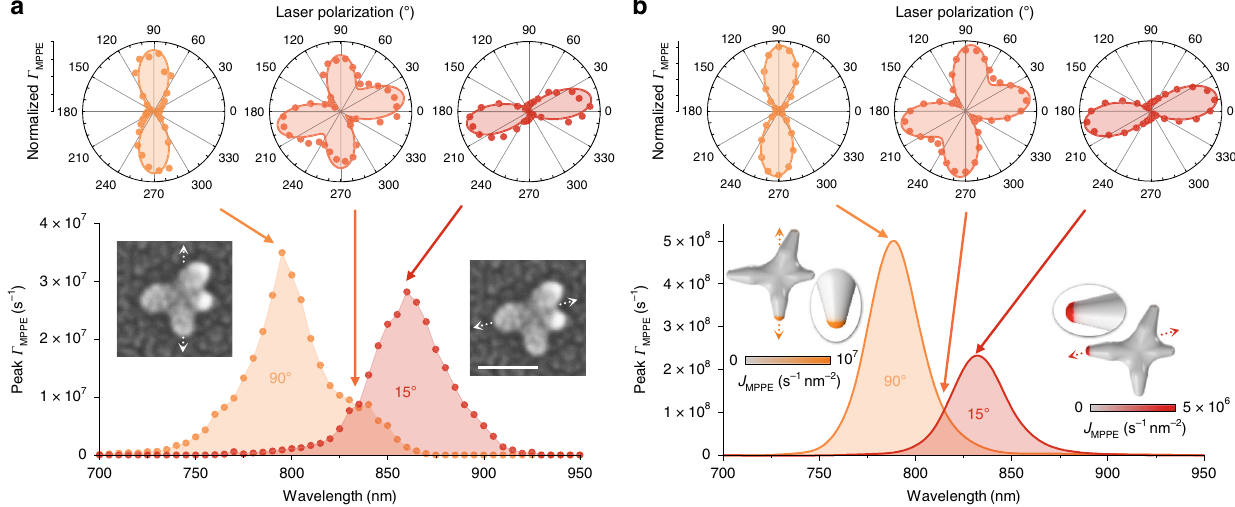
Fig. 3 Multi-tip excitation and selectivity. a Experimental slices through the optical frequency and linear polarization parameter space, with photoemission peaks at (795 nm, 90°) and (860 nm, 15°). At either spectral peak, the laser polarization dependence shows minimal signature of the other resonance, while between resonances (835 nm) the four-lobed behavior shows equal contributions from both resonance modes. The peak polarization axes are indicated in the correlated SEM insets for each resonance, as determined via nonlinear cosine fi ts shown in the polarization plots (50 nm scale bar). b Theoretical surface multiphoton photoemission rates for the correlated nanostar geometry. Aside from a small blue shift, peaks at (785 nm, 90°) and (830 nm, 15°) are in good agreement with the experimental results. All four tips are modeled with the same radius (3.4 nm), but photocurrent density maps demonstrate single-tip excitations at the resonance conditions due to the speci fi c plasmonic mode structure. Measurements and calculations are performed at 1 × 10 8 W cm − 2 peak input